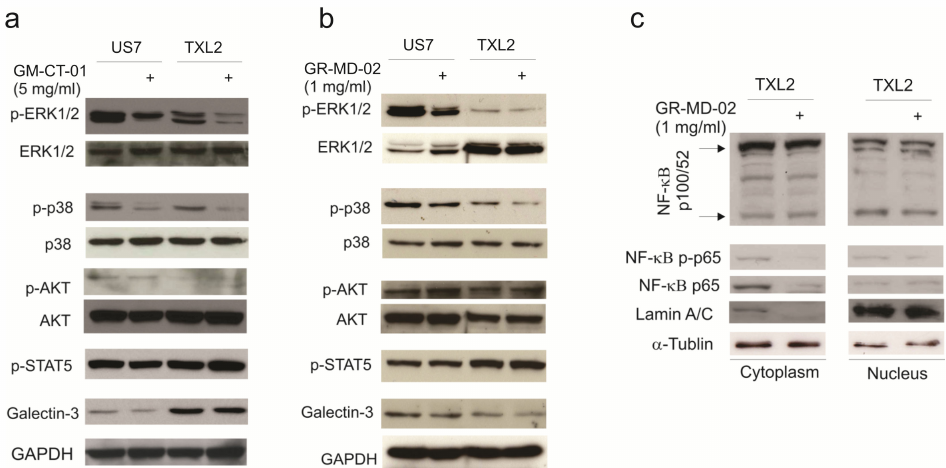
Figure 3. GM-CT-01 and GR-MD-02 attenuate mitogenic signaling in ALL cells. ( a ) Western blot analysis of US7 and TXL2 total cell lysates after incubation with 5 mg/mL GM-CT-01 for 72 h in the presence of OP9 stromal cells. After pErk1/2 antibody exposure, blots were stripped and re-probed. ( b ) US7 and TXL2 cells were incubated with 1 mg/mL GR-MD-02 for 72 h in the presence of OP9 cells. Subsequent to pErk1/2 immunoblotting, blots were stripped and reprobed. Gapdh, loading control. ( c ) NF- κ B p100/52, RelA NF- κ B p-p65 and NF- κ B p65 WB on TXL2 cytoplasmic and nuclear